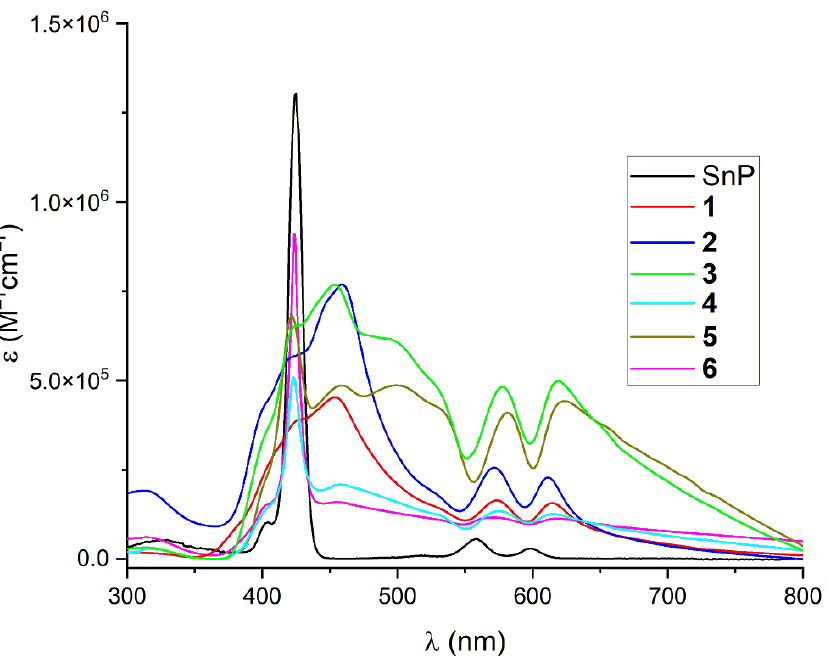
Figure 1. UV–visible spectra of triads 1 – 6 and SnP in CHCl 3 .